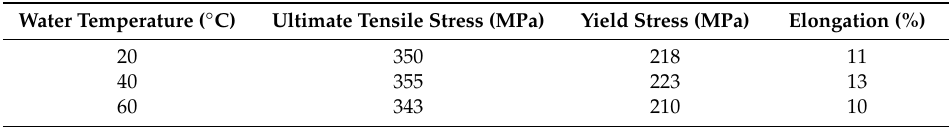
Figure 14. Predicted residual stresses contours of the 1 / 8 model for the S33 component; ( a ) 20 ◦ C; ( b ) 40 ◦ C; ( c ) 60 ◦ C. The tensile properties (MPa) of W / 2024Al composite blocks quenched by water of di ff erent